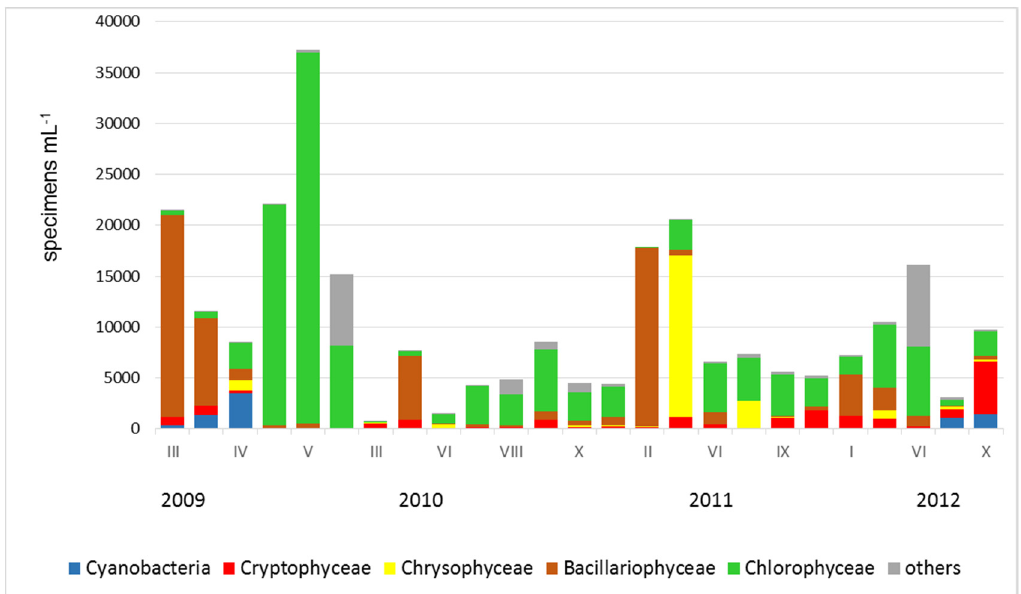
Figure 9. Contribution of taxonomical groups in the phytoplankton abundance, an example from the depth of 1 m at station A.